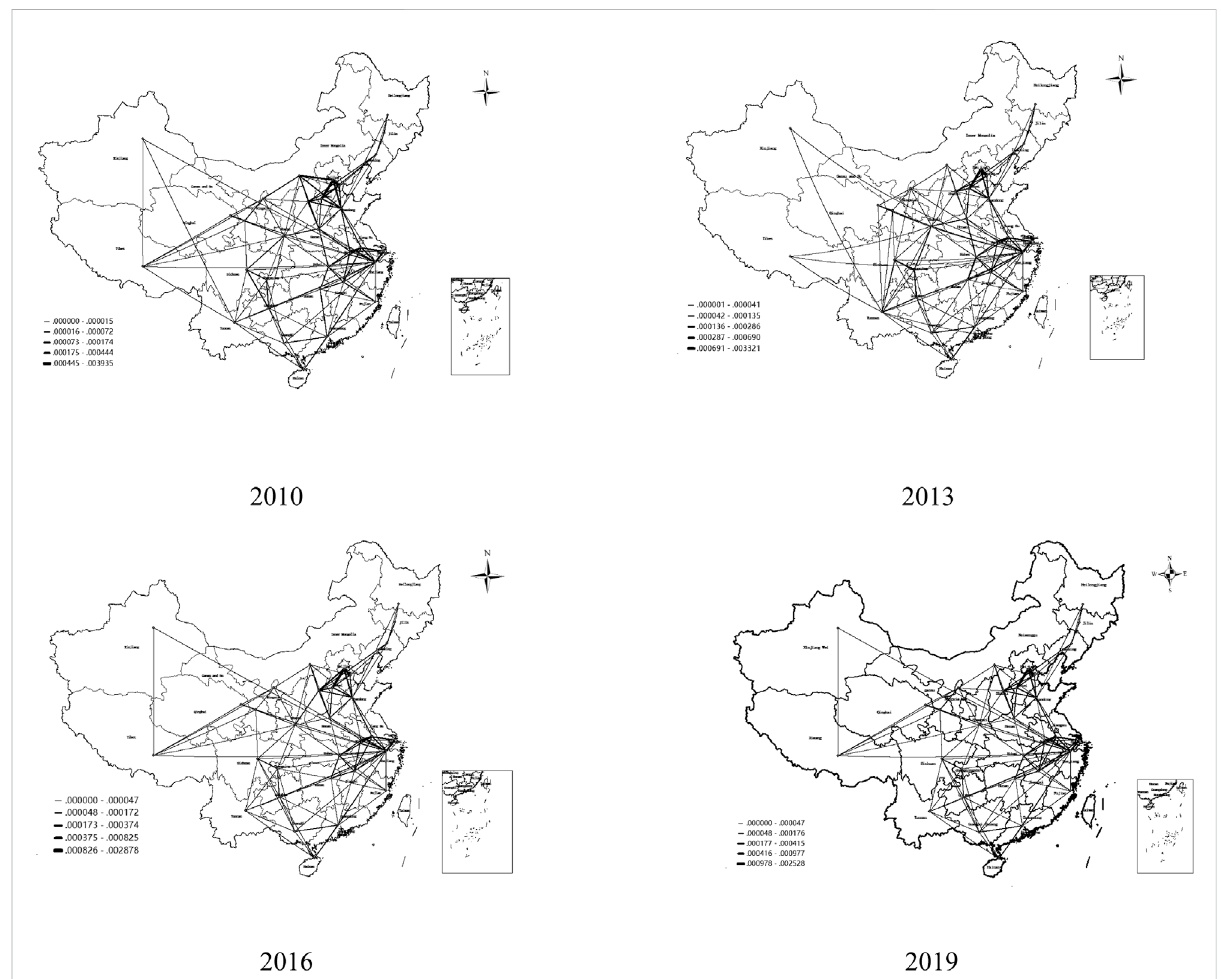
FIGURE 1 Network evolution of the impact of green fi nance development on industrial structure